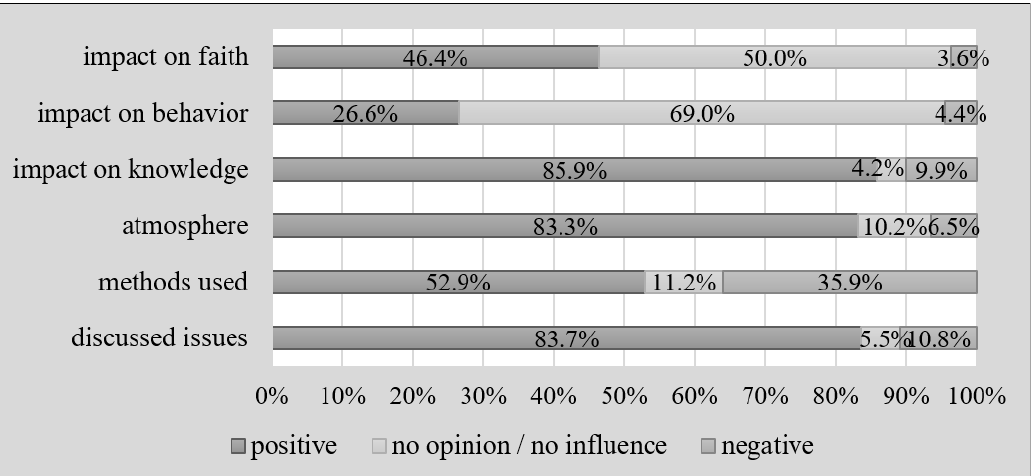
Figure 3. Assessment of selected aspects of religious education classes. (Source: own study).